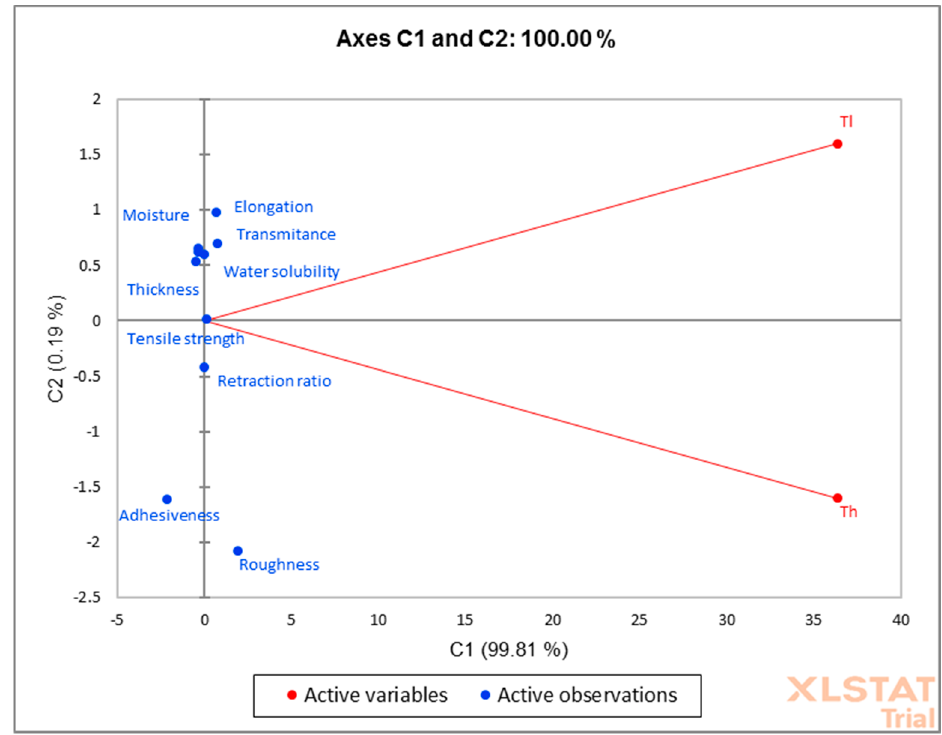
Figure 2. Principal component analysis (PCA) of the dataset consisting of analyzed parameters of film (where Th represent the highest thickness of the film and the Tl—the lowest value of film thickness). The new film can substitute conventional packaging in terms of mechanical performance. The data are noted in Table 1.